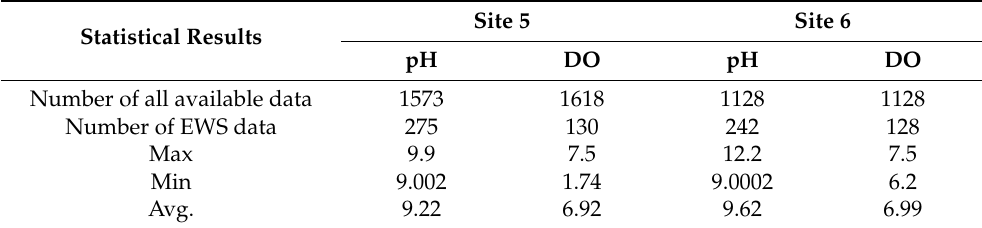
Table 5. Statistical analysis results of DO and pH for early warning at site 5 and site